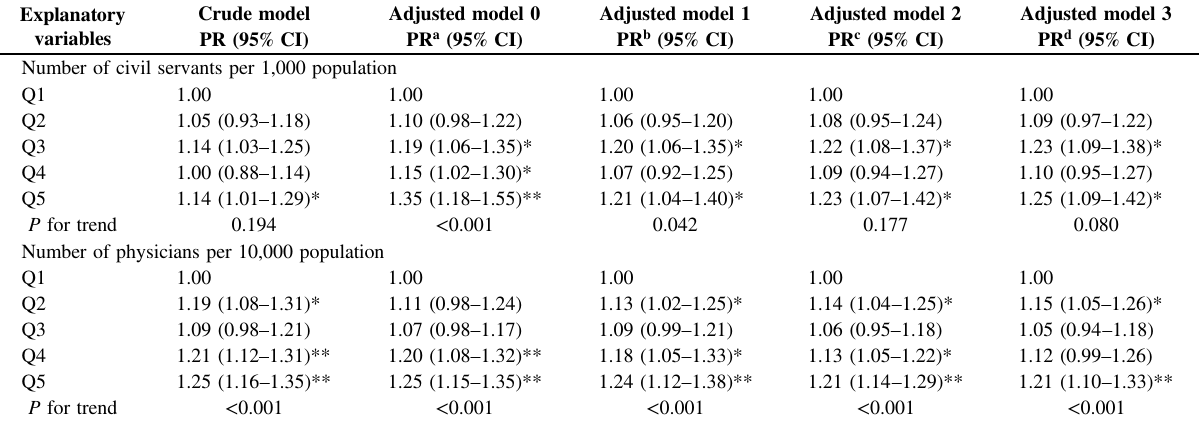
Table 2 Association of number of civil servants and physicians with rapid COVID-19 vaccination in older people Explanatory